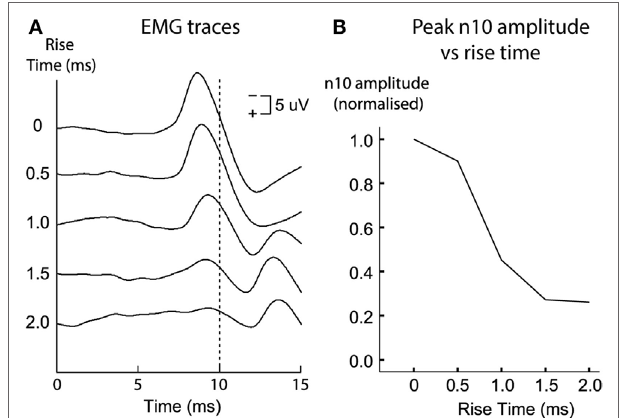
FigURe 11 | Ocular vestibular-evoked myogenic potential (oVEMP) responses [ (A) time series for each stimulus type; (B) amplitudes of the n10 peak] from a subject receiving 500 Hz bone-conducted vibration stimuli at the midline of forehead at the hairline. Tone bursts of varying rise times (ramps) were presented in random order. The size of the n10 component of the oVEMP depends on the rise-time of the tone burst stimulus: increasing the rise time causes a systematic reduction of the n10 amplitude. This is quantified in panel (B) , where n10 amplitude is plotted against rise-time. Reprinted by permission from Wolters Kluwer Health, Inc.: Burgess et al. (98), ©